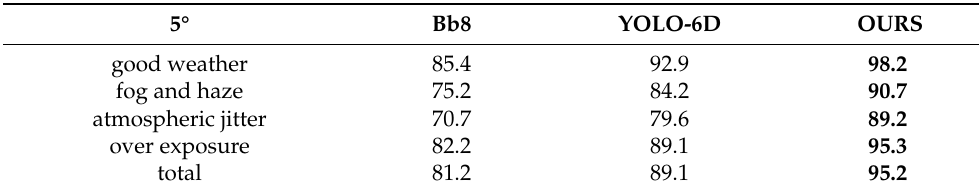
Table 4. Comparison with the state-of-the-art methods in terms of the ∆ R metric on APE dataset. Bold number indicates the best